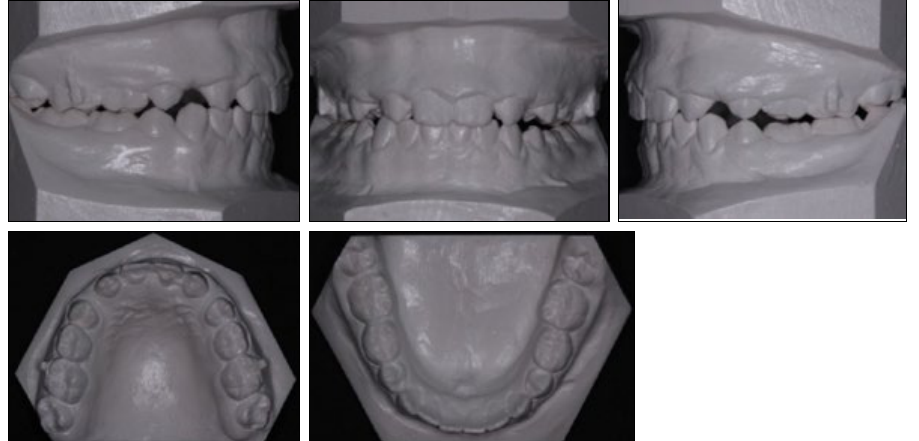
Figure 4. Photographs of pretreatment dental